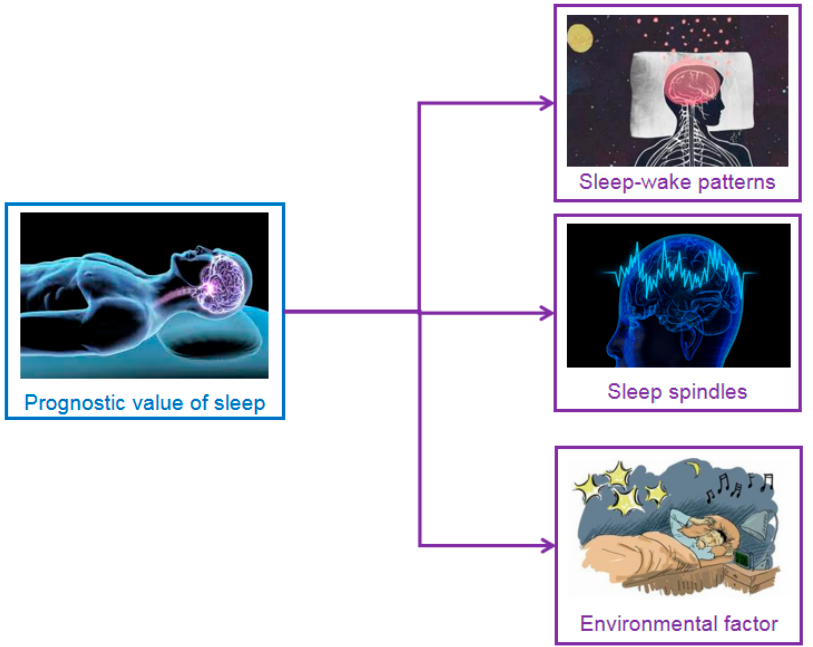
Figure 4. Prognosis factor of sleep for DOC patients. The prognostic value of sleep is summarized into sleep spindles, organized sleep–wake patterns and environmental